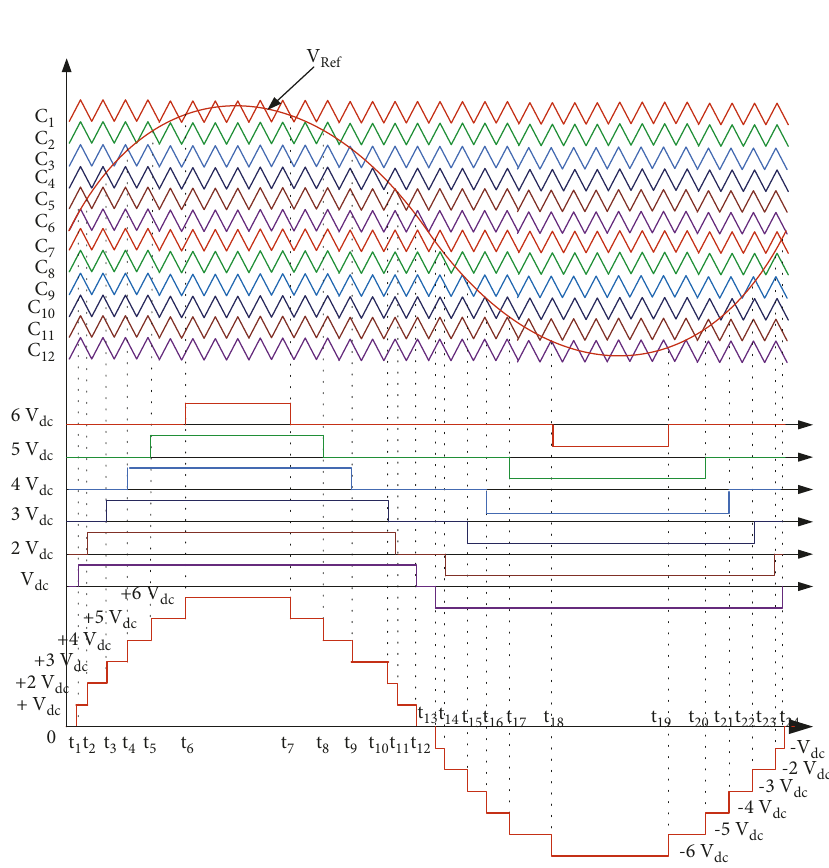
Figure 3: PWM control logic.